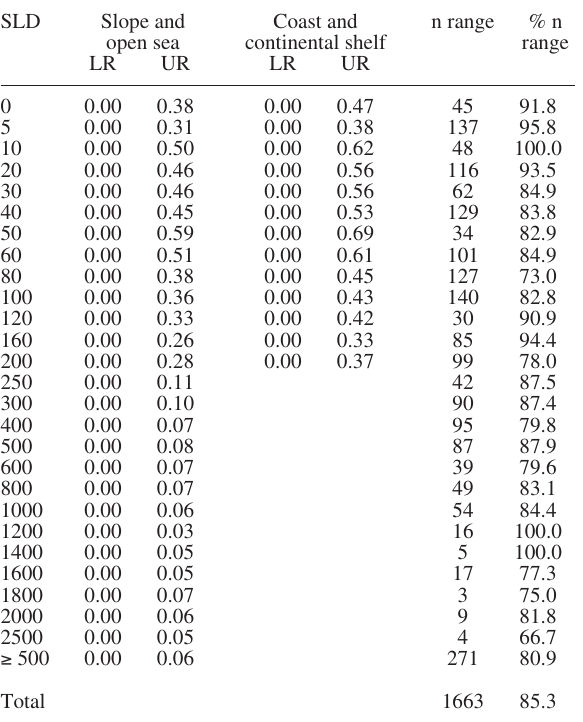
Table 11. – Nitrite concentration ( m M) ranges in the NW Mediter- ranean Sea in mixed water columns (stratification coefficient = 1). Headers as in Table